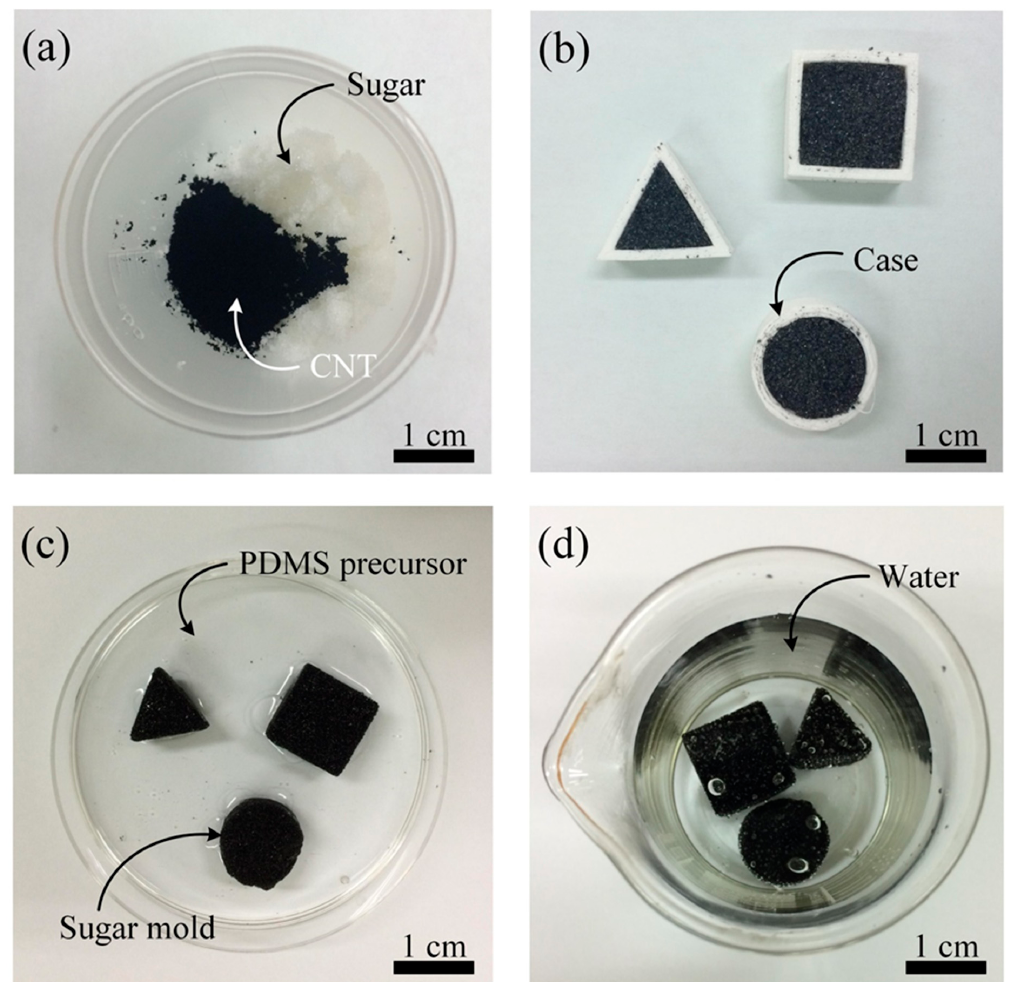
Figure 1. Fabrication process of carbon nanotube (CNT)/polydimethylsiloxane (PDMS) composite structures (CPCSs). ( a ) Mixing sugar, water, and CNTs. ( b ) Mixture casting into cases of desired shapes. ( c ) Separation of the sugar cube mixed with the CNTs from the mold and PDMS precursor infiltration in the cube sugar in a vacuum chamber. ( d ) PDMS thermal curing and dissolution of sugar with water.